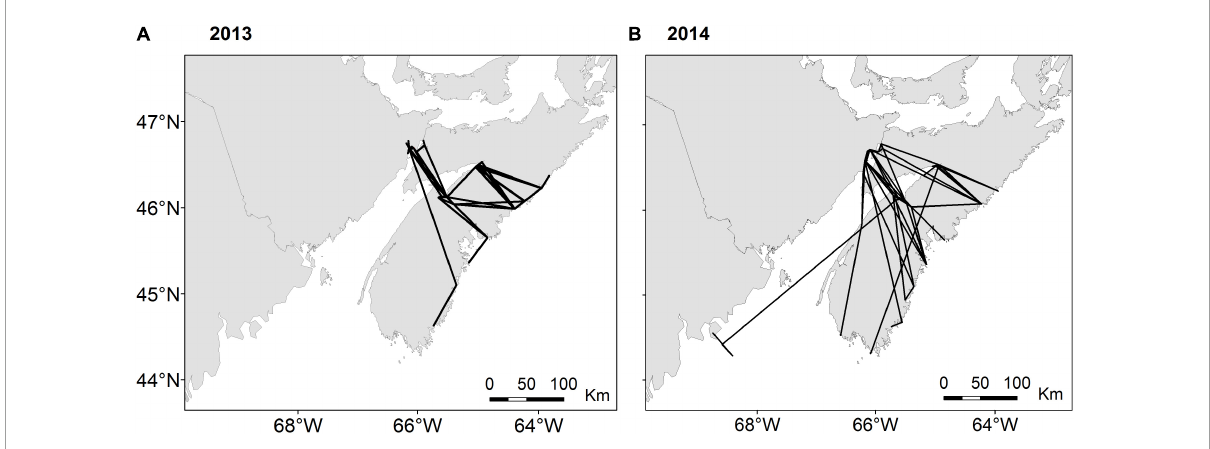
FIGURE4 Routes taken by all Semipalmated Sandpipers detected following departure from the Bay of Fundy in (A) 2013 ( N = 37) and (B) 2014 ( N = 55). All detections along the outer coast were “fly-by” events where individuals were detected for < 1 h.